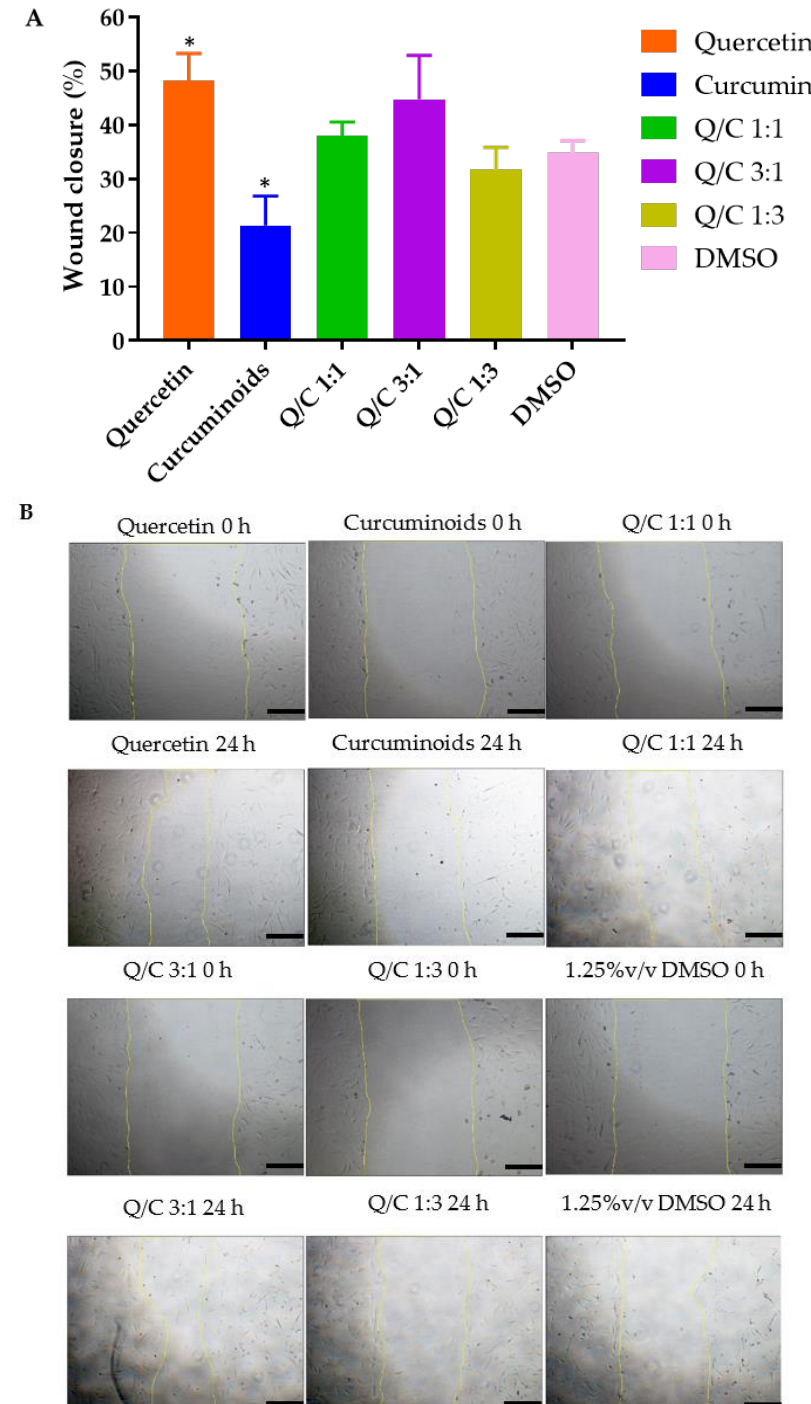
Figure 4. ( A ) Quantitative analysis of the migration area reported as %wound closure. ( B ) Representative images of HDFB cells in a wound scratch assay. The images were taken immediately after the scratches had been made and then after 24 h in the presence and absence of quercetin, curcuminoids and quercetin/curcuminoid mixtures. Data represent mean ± S.D. ( n = 3). * p < 0.05 for comparison with control (DMSO). Scale bars represent 200 µm. Migration